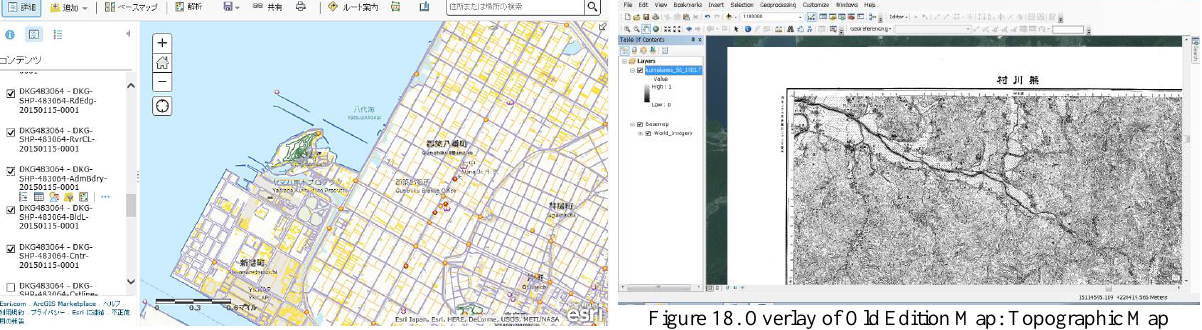
Figure 18. Overlay of Old Edition Map: Topographic Map (Japan) in ArcGIS Online with 0% transparancy